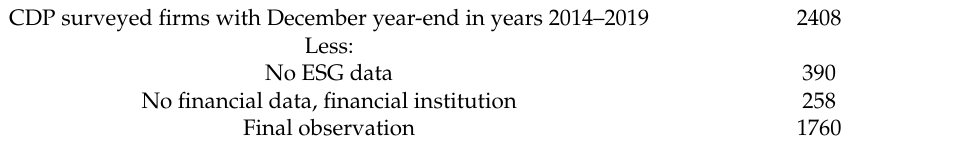
Table 2. The data selection